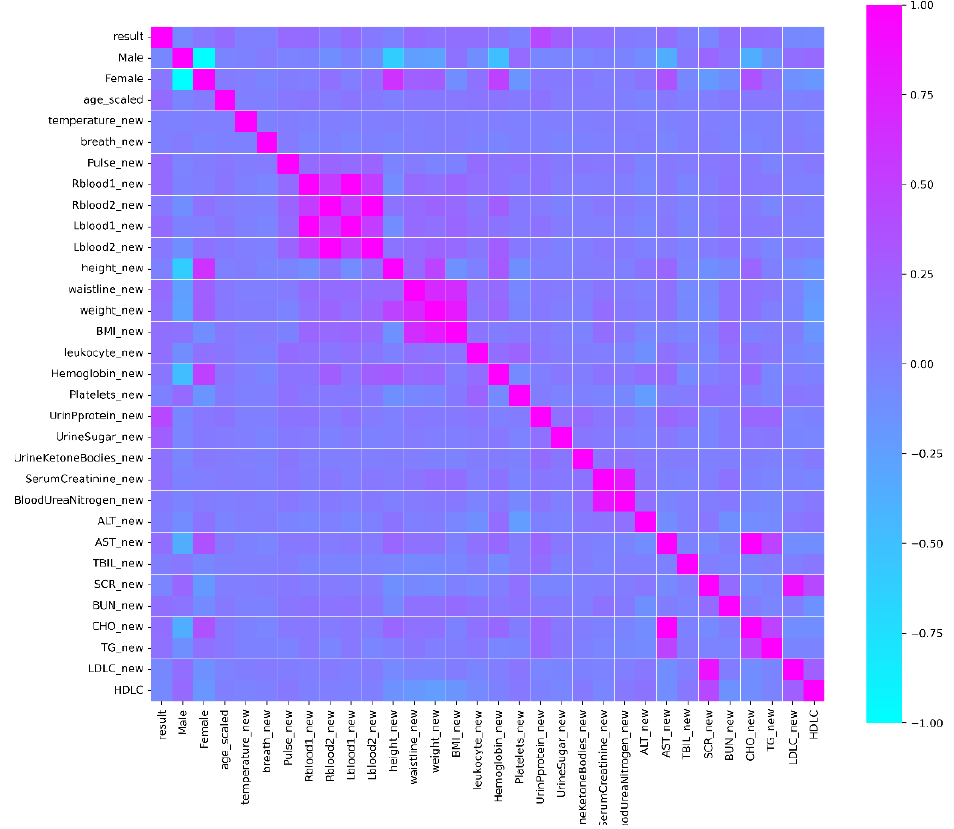
Figure 3. Feature correlation heatmap.